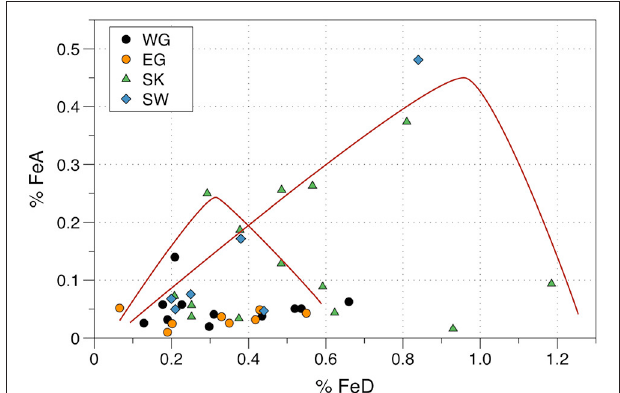
FIGURE 2 | Relationship between FeA wt. % and FeD wt. % for Arctic iceberg sediments. Data from Raiswell et al. (2016). Localities are Wallensbergfjorden (Svalbard, SW), Kongsfjord (Svalbard, SK), Sermilk (East Greenland, EG), and Narsarsuaq (West Greenland, WG). Red lines represent possible pathways of FeA formation by weathering and loss by transformation in different iceberg